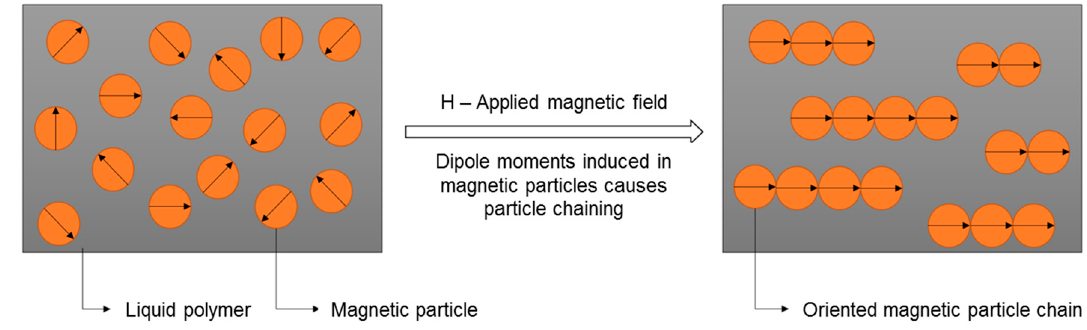
Figure 1. Schematic of magnetic field-induced particle structuring in magnetic polymer composite.